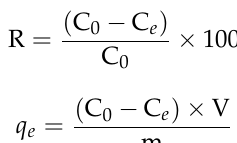
Table 1. Chemical structure and normalized cost of different surfactants.